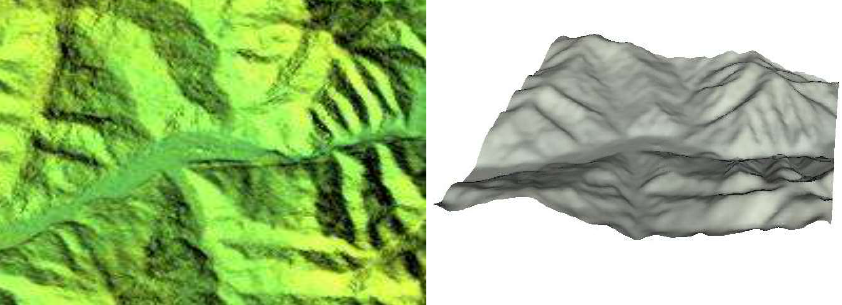
Figure 13. Digital terrain model in the module: left) AERMAP; right) 3D Analyst.